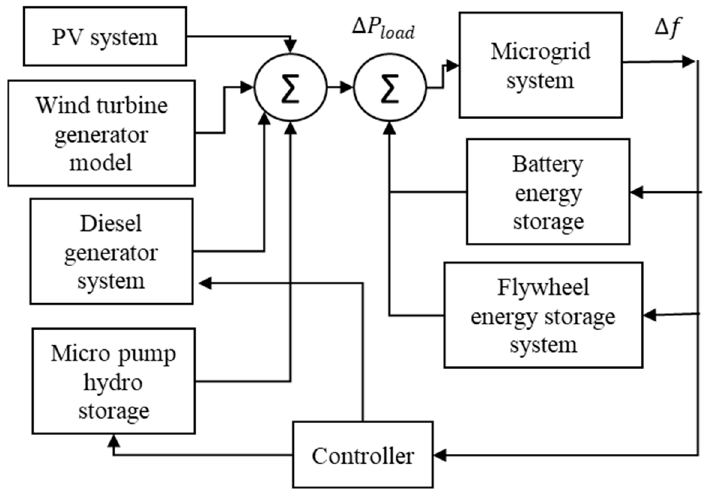
Figure 5. Frequency response model for the